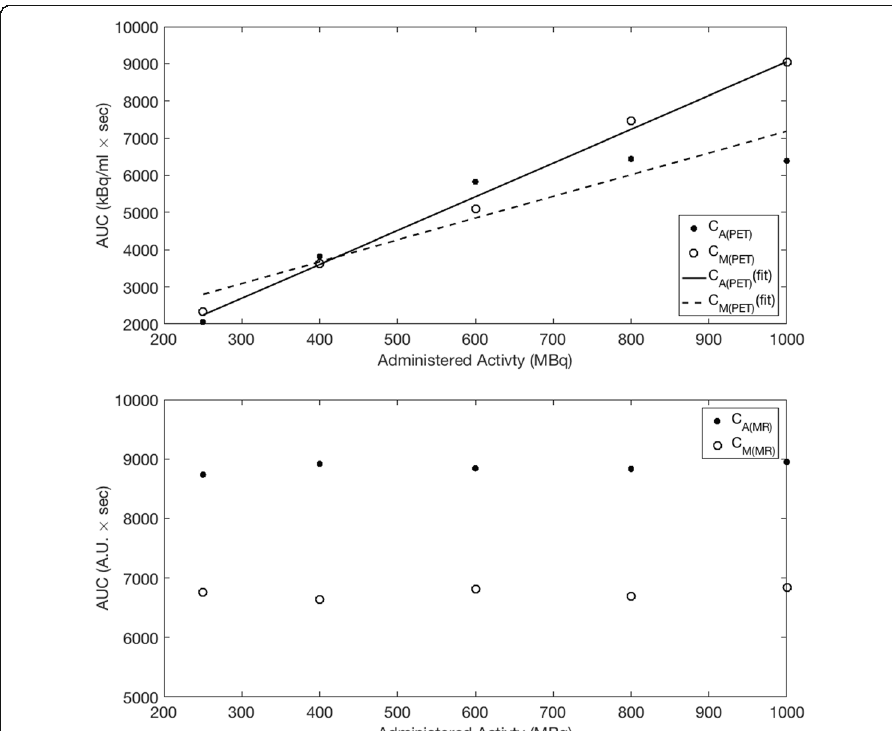
Fig. 6 Area under the curves for (top) C A (PET) , C M (PET) , (bottom) C A (MR) and C M (MR) . AUC increase linearly for A R 2 = 0.99), whereas the effect of count losses is observed for C A C M (PET) up to INJ = 997 MBq (